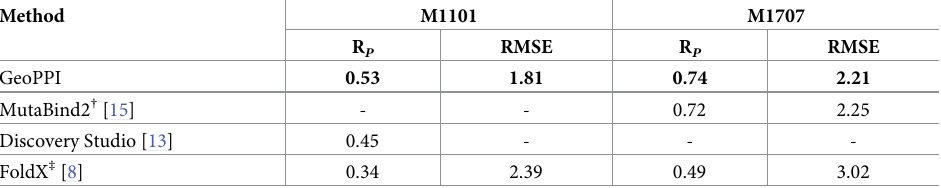
Table 2. Comparison of individual methods for the multi-point mutations in SSCV in terms of Pearson correla- tion coefficient ( R P ) and root-mean-square error (RMSE) on the M1101 and M1707 datasets. The dash sign indi- cates the results of the corresponding methods are not available. † : Results were obtained based on the released data. ‡ : Results were obtained via the released